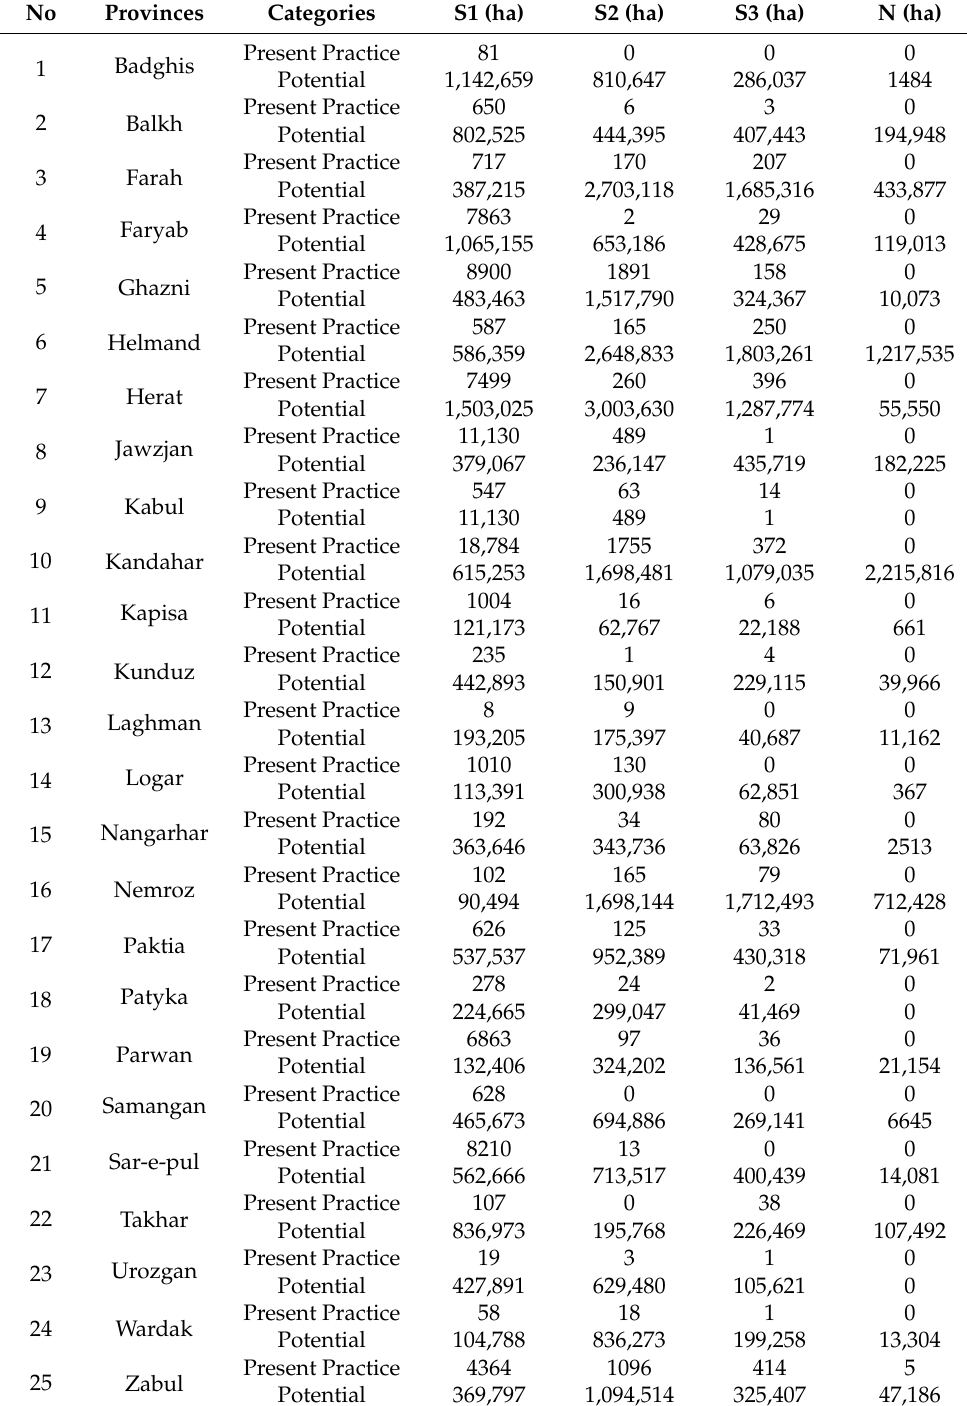
Table 5. Vineyard locations and potential for vineyard extension at different suitability classes distributed among the provinces of